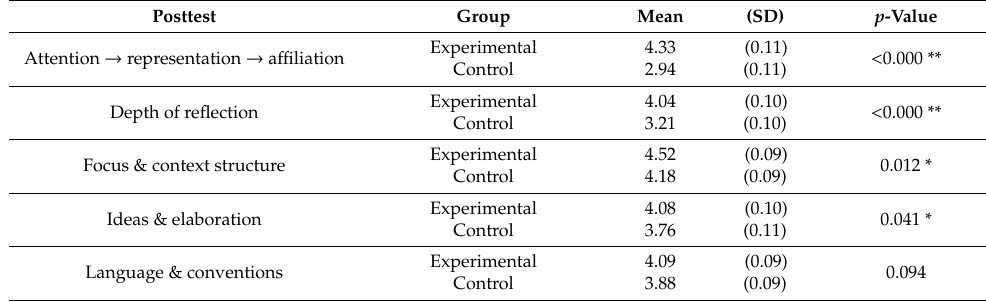
Table 10. MANCOVA and the adjusted posttest means for the